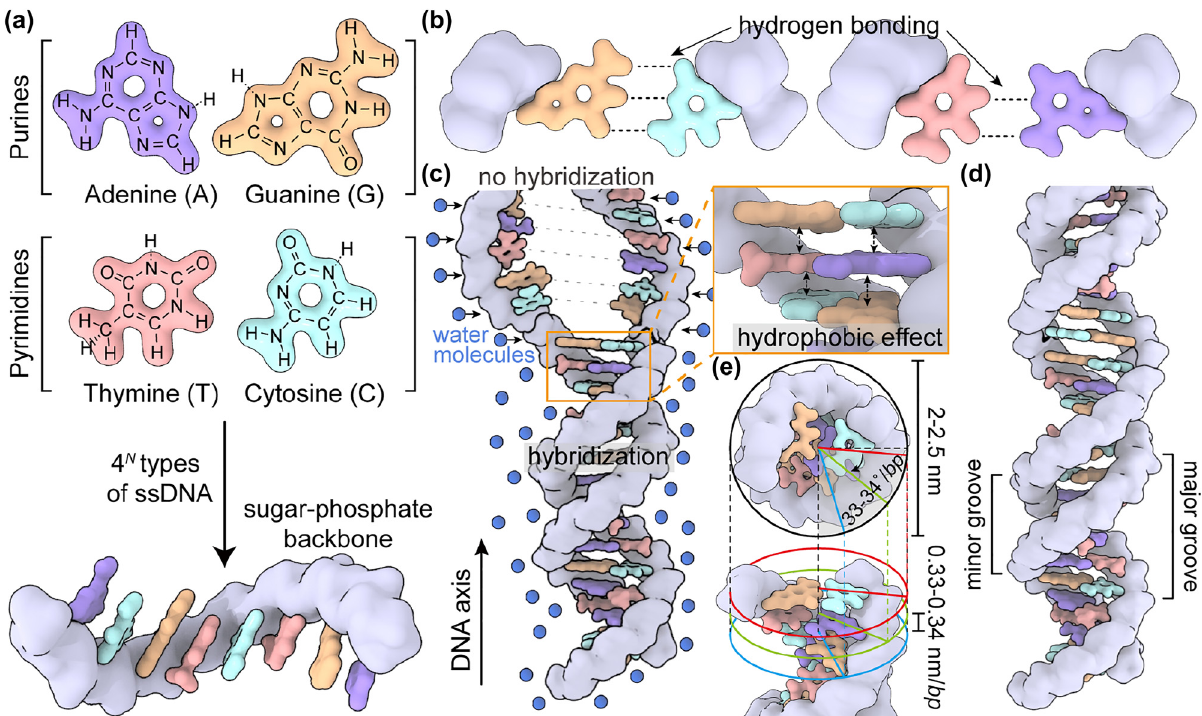
Figure 1: Schematic representations for fundamental of DNA, (a) the basic building block of DNA strand, composed of 4 different nucleotides including Adenine (A), Guanine (G), Thymine (T), and Cytosine (C) with sugar-phosphate backbone. (b) The different number of hydrogen binding sites between G with C and T with A respectively. (c) The hybridized bp can be stacked along the DNA axis. The unsolvable bp gets closer by surrounded water molecules through hydrophobic effect (in orange box) (d) entire scheme on twisted B-form DNA duplex. Along the helically twisted form, the major and minor groove have been labeled. (e) Top and perspective view of DNA duplex to show the width of 2–2.5 nm, rotational angle of 33 ∼ 34 ◦ / bp and distance of 0.33–0.34 nm/ bp ,